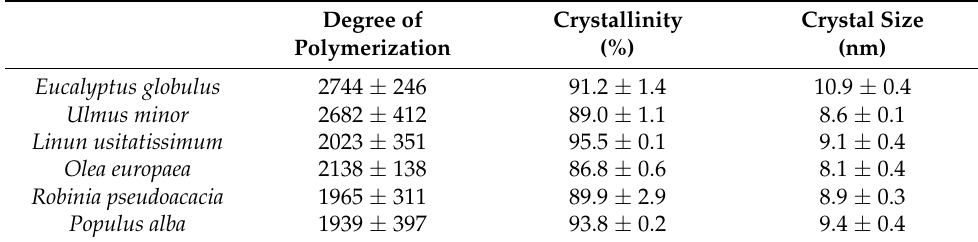
Table 2. Degree of polymerization, cellulose crystallinity, and crystal size of cellulose samples. Degree of Polymerization